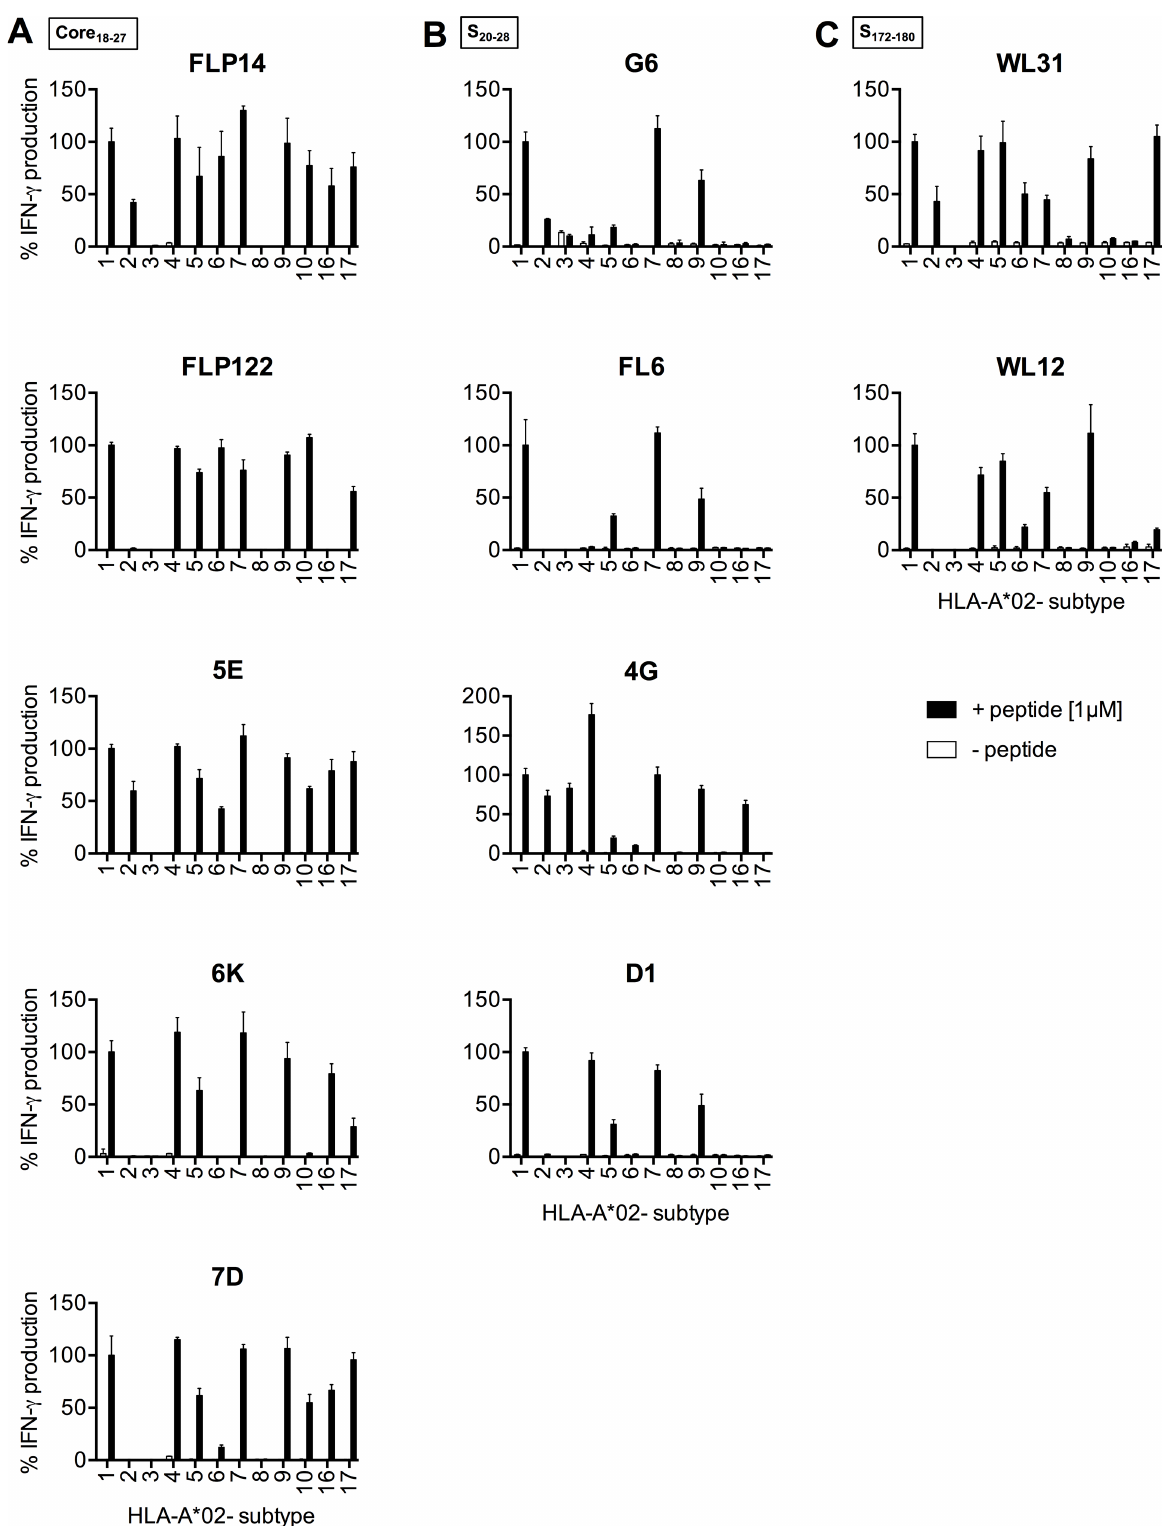
Fig 4. Recognition of different HLA-A * 02subtypes. LCL with varyingHLA-A * 02subtypes were loadedwith HBV peptides (1 μ M) and co-cultured with TCR-transducedC18-specific(A), S20-specific (B) or S172-specific (C) CD8 + T cells (E:T 1:1). T-cell activation